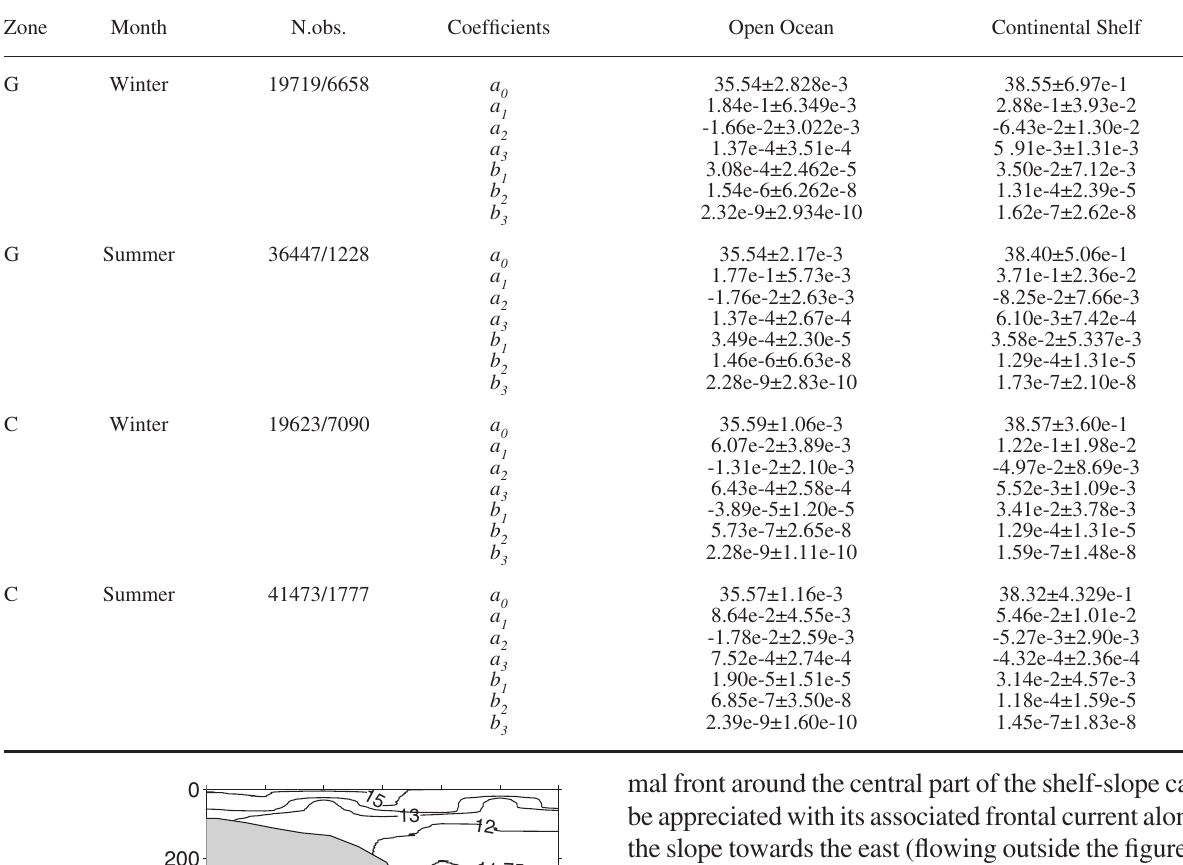
Table 3. – Polynomial coefficients obtained to retrieve salinity as a function of temperature and depth in the Galician Area (G) and Cantabrian Sea (C) during winter-like and summer-like seasons in the interior ocean and continental shelf.